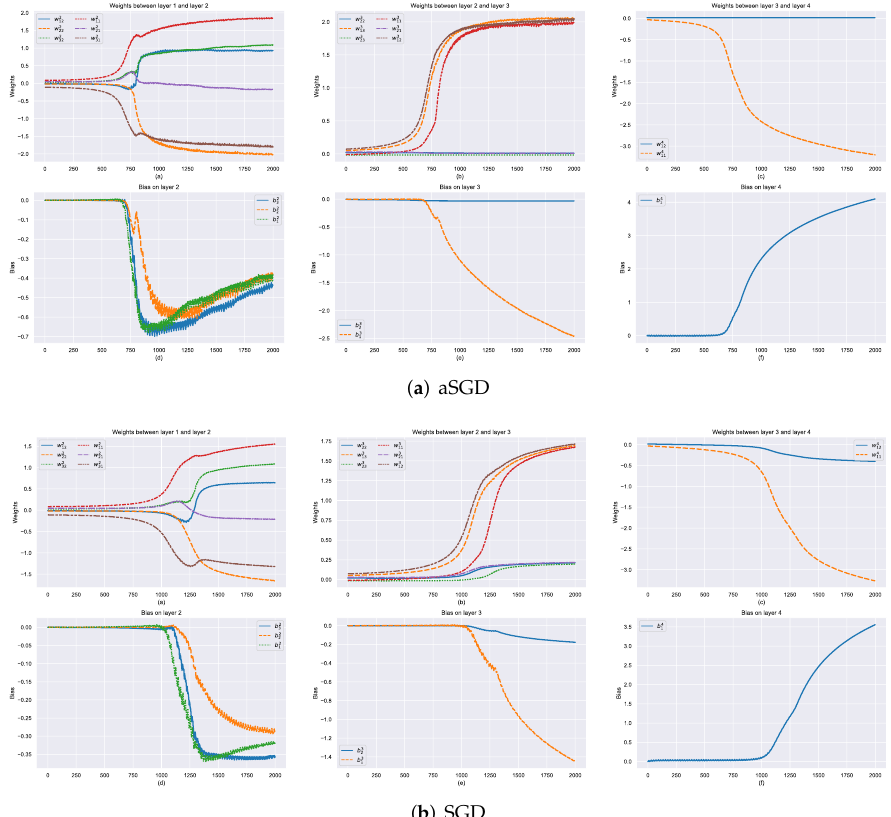
Figure 4. The values of each parameter of the model for Experiment 1 during training process with ( a ) aSGD and ( b ) SGD. Each subfigure represents the parameters in a layer of the network. The horizontal coordinate is the number of iterations, and the vertical coordinate is the value of the parameter. Each line represents a parameter, including weights and bias. The same parameter is the same color in ( a ) aSGD and ( b )